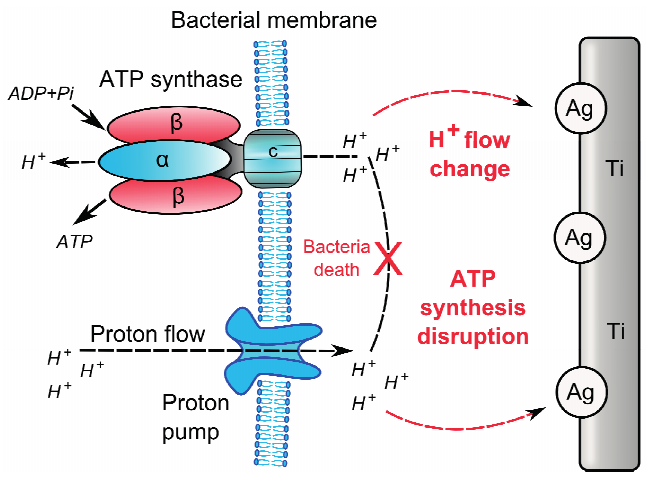
Figure 6. Plasma-surface modification techniques creating a special type of antimicrobial surface involving silver (Ag) nanoparticles embedded into titanium (Ti); it is proposed that Ag and Ti represent a micro-galvanic pair with different potentials in the presence of electrolyte solution; the cathodic reaction will create a proton-depleted region between bacterial membrane and Ti substrate, which leads to disruption of the adenosine triphosphate synthesis and bacteria